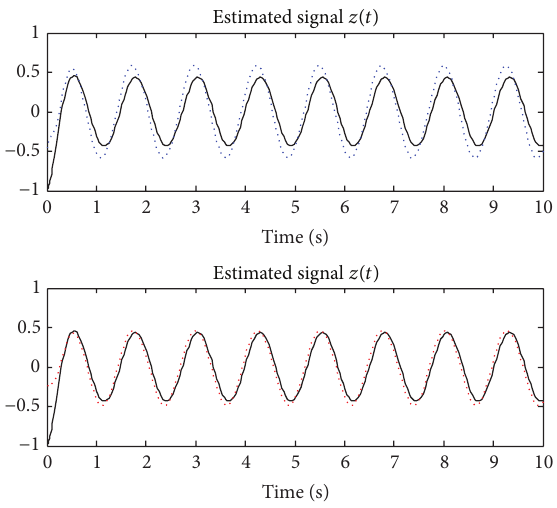
Figure 3: Filtering results for 𝑤(𝑡) = 0.5 sin (5𝑡)